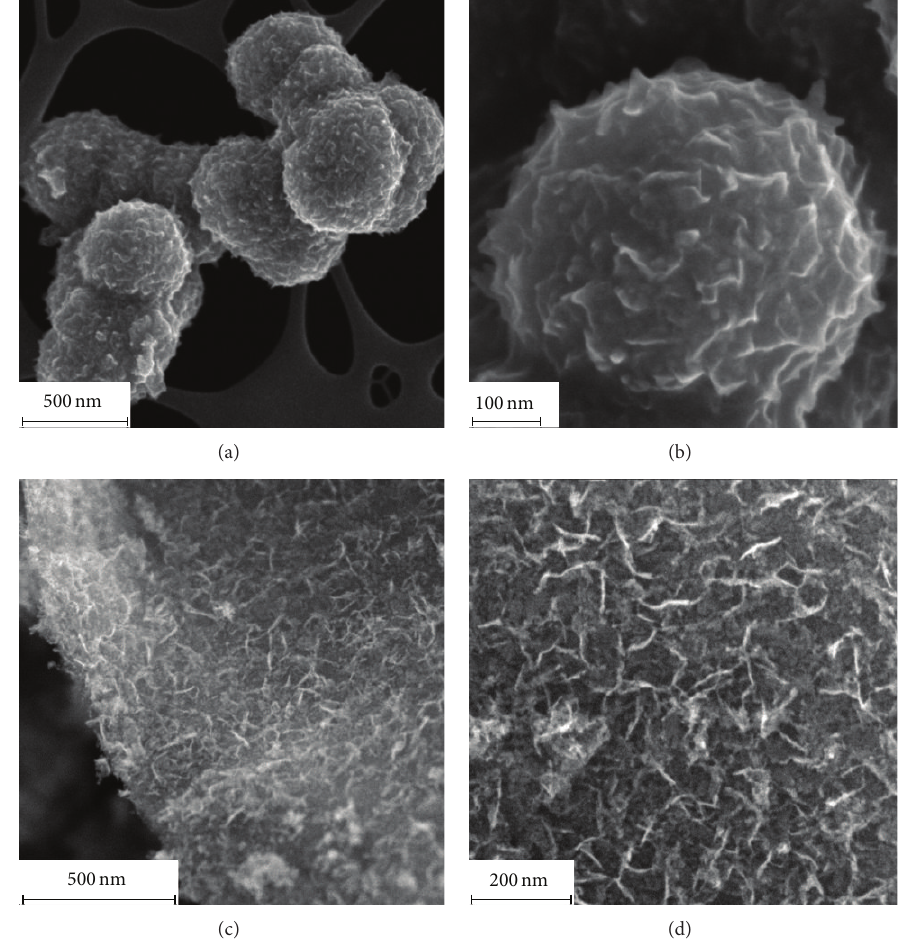
Figure 3: FESEM images of ((a), (b)) TiO 2 and ((c), (d)) RGO-TiO 2